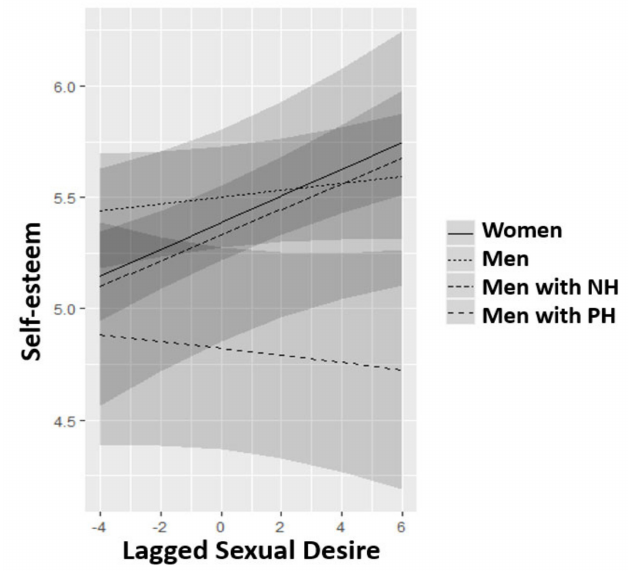
Figure 4. The effect of lagged self-esteem on current sexual desire for women, men, men with NH, and men with PH. For women and for men with NH an increase in the preceding sexual desire forecasted an increase in current self-esteem. Shaded areas represent 95% confidence